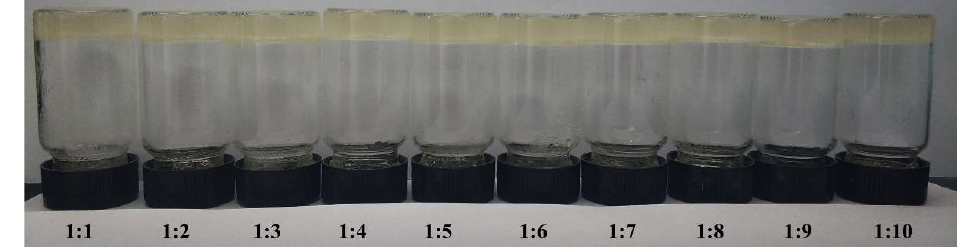
Figure 7. Photos of gels formed in THF; the ratio of THF to water is 1:1 to 1:10 ( v/v ). The volume of mixed solution in every part was 2 mL.